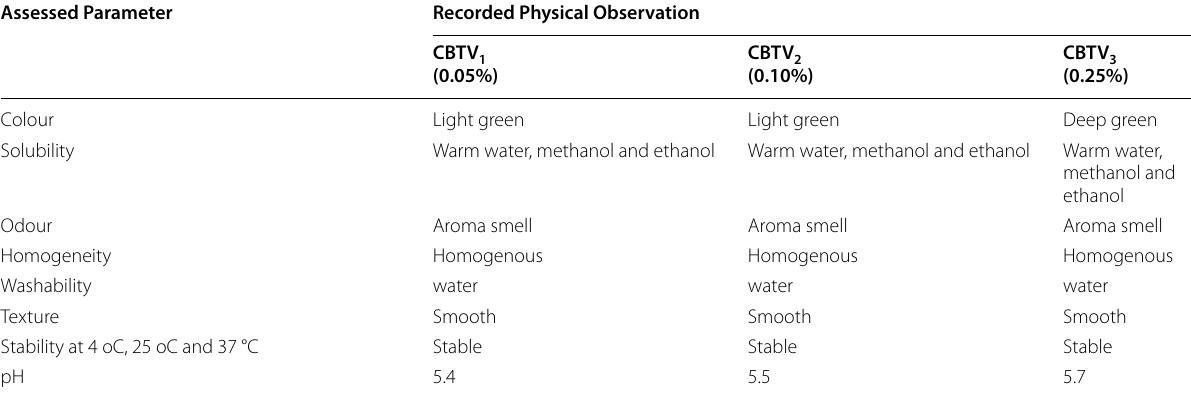
Table 2 Physicochemical assessment of the herbal cream formulations Assessed Parameter